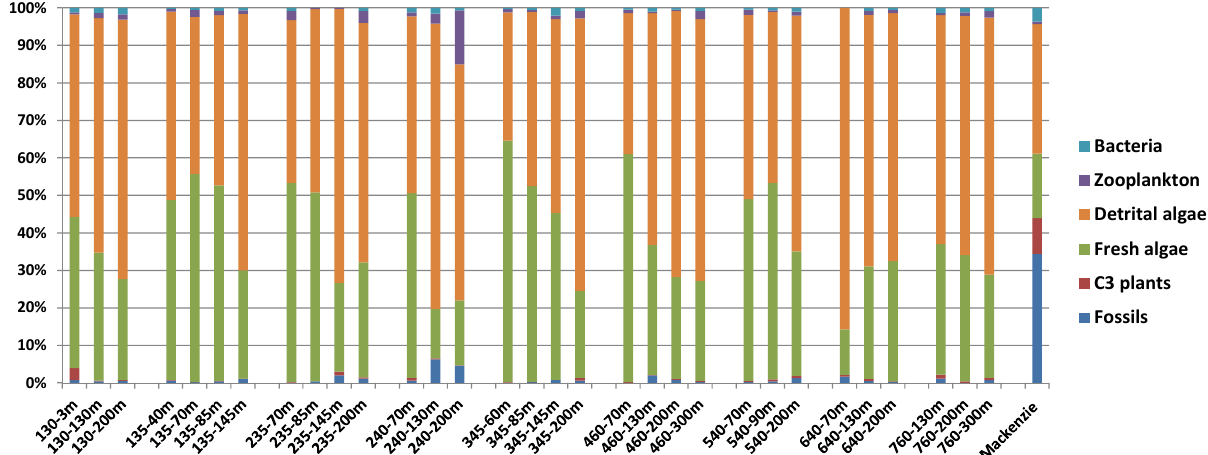
Fig. 5. Relative contributions of OM constituents in the SPM from the Mackenzie River and in the offshore waters from the Mackenzie slope. The molecular biomarkers were separated into the following components: fossil (UCM, and petroleum hydrocarbons), fresh/labile algal (PUFA, phytol, IP 25 , n -C 21 : 6 , C 28 1 5 , 24 ( 28 ) , C 29 1 5 , 24 ( 28 ) ) , refractory/detrital algal (SCFA, SCMUFA, rest of sterols, biogenic alkanes, SCOH, SCMUOH), zooplankton (LCMUFA, LCMUOH), bacterial (branched FA) and C 3 terrestrial plants (LCFA, LCOH, wax n -alkanes). For the Mackenzie River, C 18 : 1 ω 7 FA and C 29 1 5 were included within respectively the bacterial and terrestrial component.